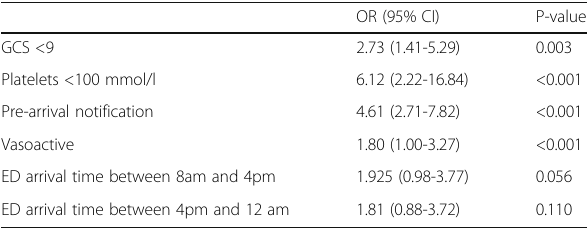
Table 1 (abstract 0208). Multivariate